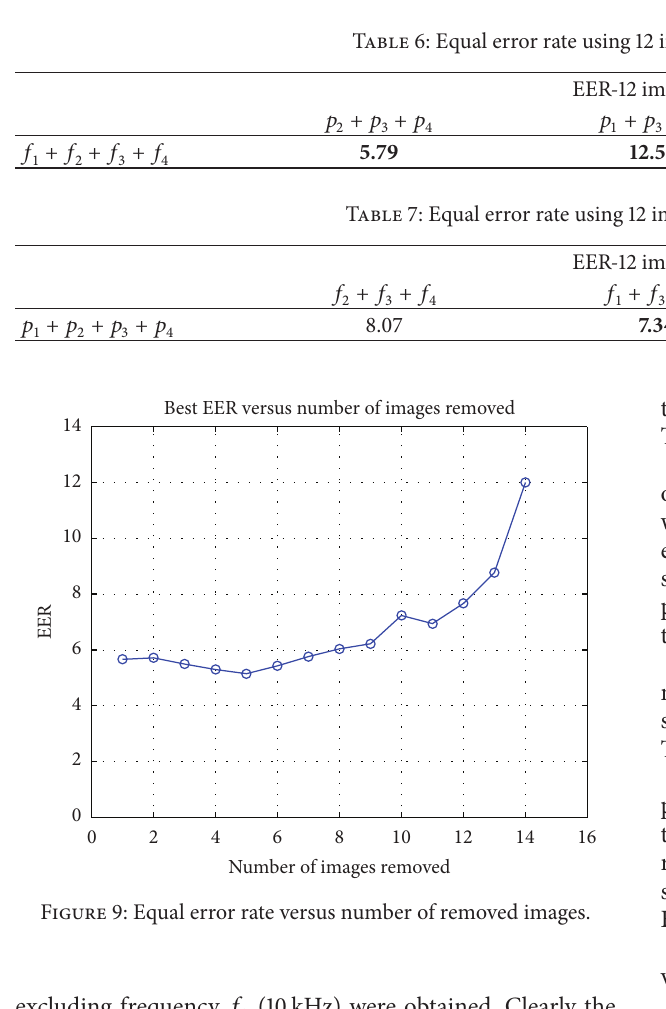
excluding frequency 𝑓 3 (10 kHz) were obtained. Clearly the differences associated with the discarded frequencies were of little significance (EER maximum and minimum ratio =